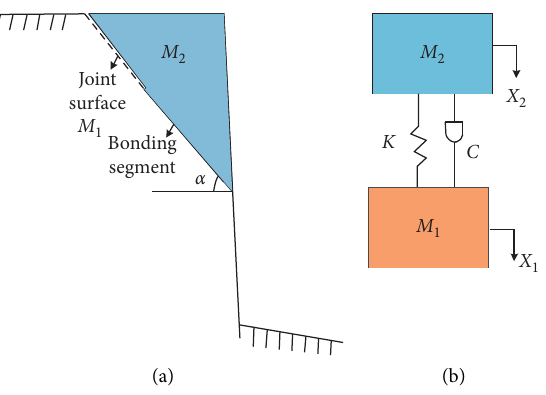
Figure 2: Vibration model of jointed rock